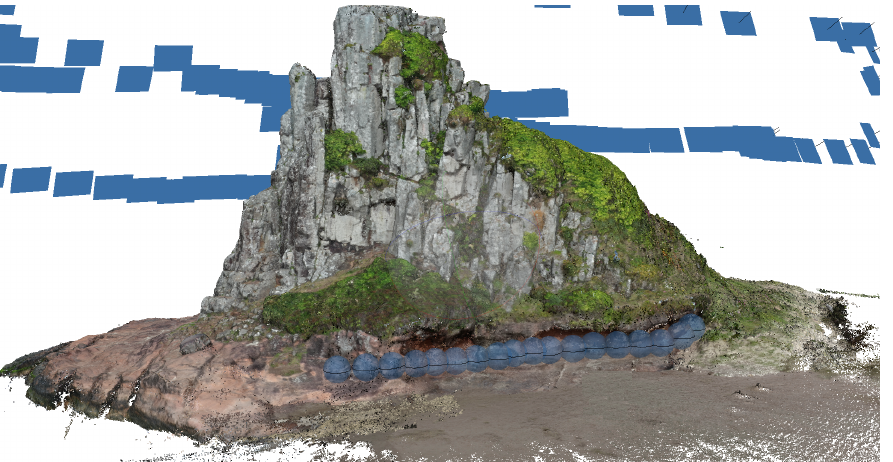
Figure 8. 3D representation of the final point cloud, with viewing perspectives in light blue (frames for UAV and spheres for SPI).